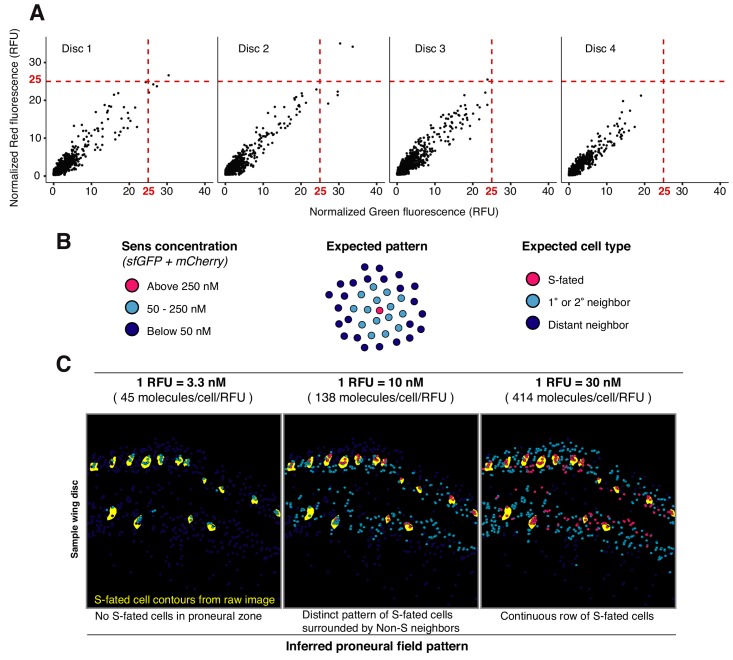
Calibrating a conversion factor between confocal microscopy fluorescence and FCS molecule counting.(A) Relative fluorescence intensity (RFU) for cells in four fixed wing discs is shown. Red dashed lines mark the estimated maxima for Sens expression at 25 RFU, corresponding to 250 nM maxima measured by FCS in Figure 1G (B) Expected arrangement of S-fated cells (magenta), first or second degree neighbors (cyan), and distant neighbors (dark blue) within Sens-positive stripes adjacent to the DV boundary. Cells were categorized into distinct classes based on total Sens concentration measured by FCS (left). (C) Fluorescence signal intensity (RFU) from imaged cells was converted into concentration (nM) by multiplying with a particular conversion factor. Cell coordinates were then mapped in space and color-coded according to their expected cell category (defined in (B)). Contours of S-fated cells were identified from raw microscopy images and are shown in yellow. Three conversion factors were tested, as shown at top. The factors differed from one another across a nine-fold range. Only a conversion factor of 10 nM/RFU (center column) was able to recapitulate the expected pattern of S-fated cells. Three representative discs are shown. Decreasing the factor to 3.3 (left) eliminated S-fated cells. Increasing the factor to 30 (right) produced a continuous row of S-fated cells. Thus, we estimate the conversion factor to be within an order of magnitude of the estimated conversion of 1 RFU equivalent to 10 nM.